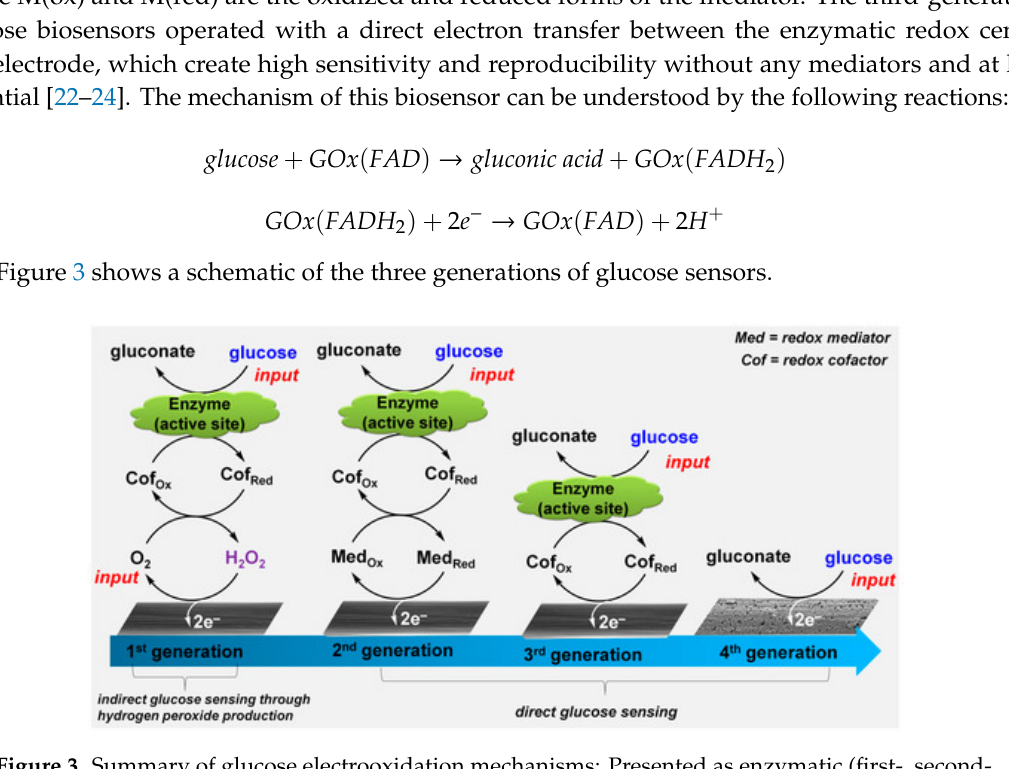
Figure 3. Summary of glucose electrooxidation mechanisms: Presented as enzymatic (first-, second-, and third-generation sensors) and non-enzymatic (so-called herein “fourth-generation” sensors).